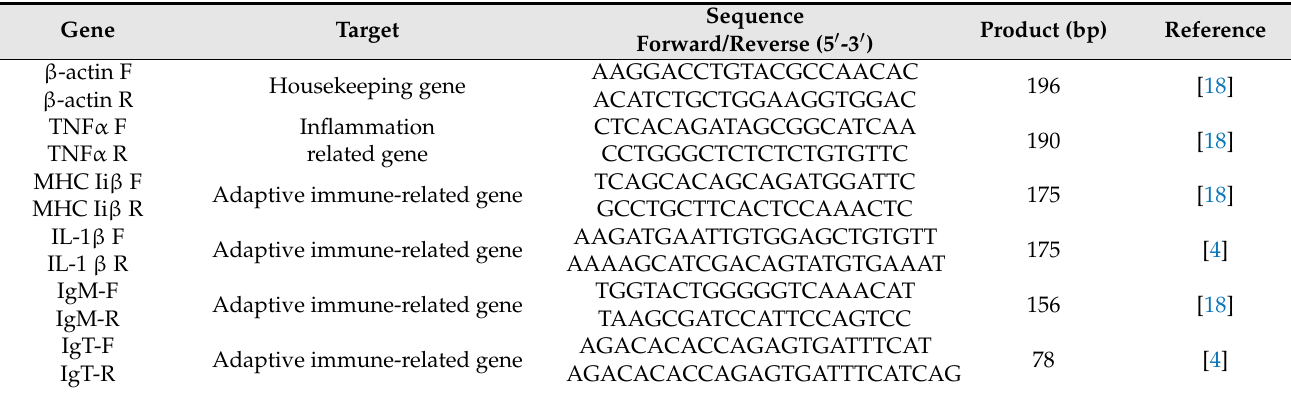
Table 1. Primers used in